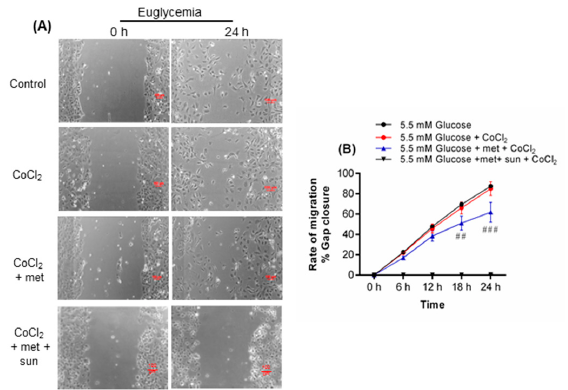
Figure 1. Metformin impairs cell migration in HUVEC exposed to euglycemia and CoCl 2 . ( A ) HUVEC were incubated for 24 h with euglycemia in the presence or absence of metformin. Scratch lines were created on confluent monolayers. The media containing different glucose concentrations and metformin were replaced. Then cells were incubated with CoCl 2 for 24 h in a 5% CO 2 chamber that was connected to CCD camera. Images were acquired every hour, and three independent biological experiments were performed at which each condition was assessed in duplicate. The scratch area was measured using NIS Elements software. ( B ) CoCl 2 induction exhibited no significant effect on cell migration under euglycemia, whereas metformin reduced migration after 18 h. Sunitinib (0.1 µmol/L) was used as a negative control, therefore the line with sunitinab is on x axis as cell migration not affected. Results are expressed as mean ± SEM and were analyzed by one-way ANOVA followed by LSD, ## p < 0.01, ### p < 0.001 compared pairwise, i.e., the metformin-treated versus metformin-untreated condition. Scale bar is 100 µ m. Key: met: metformin; sun: sunitinib.